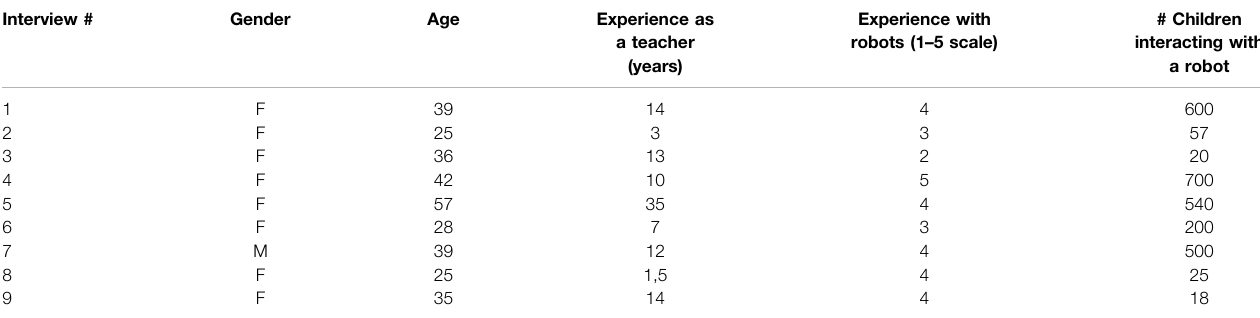
TABLE 1 | Data on participants in the